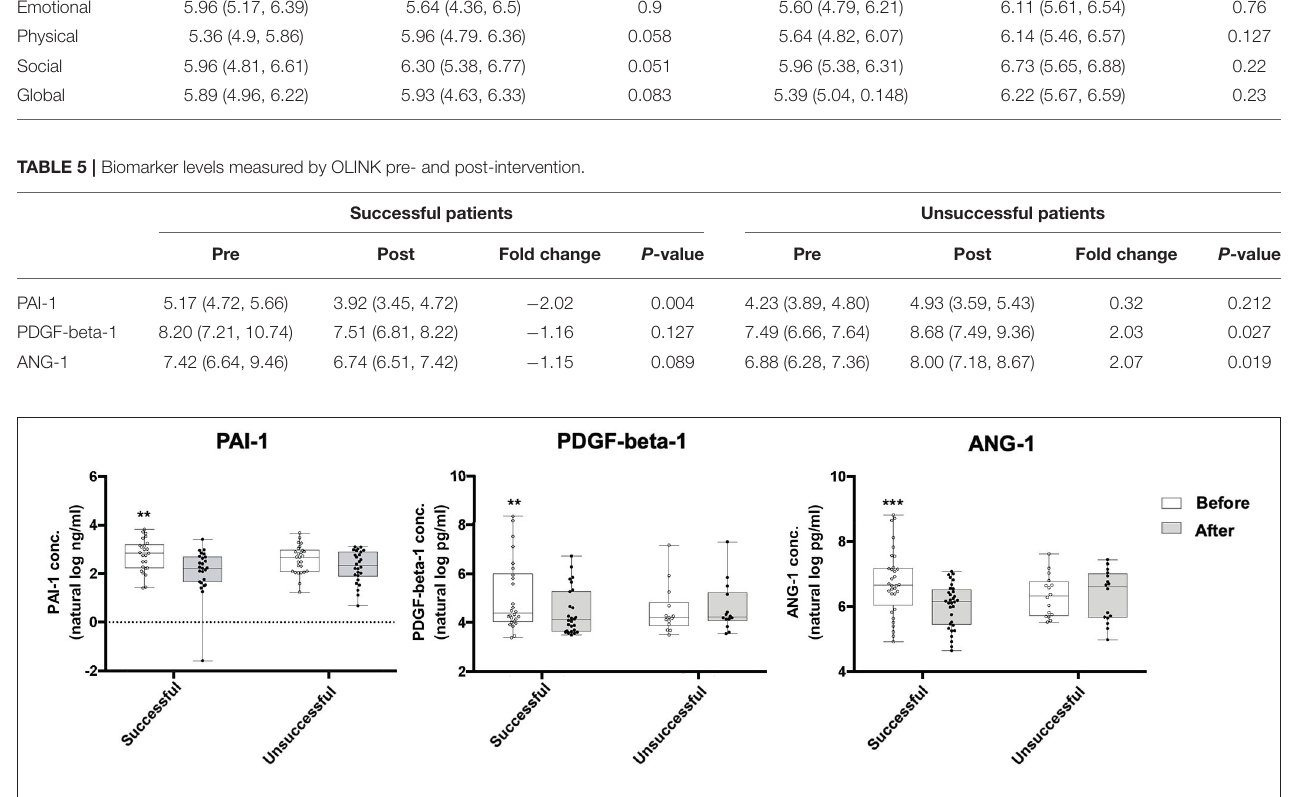
FIGURE 3 | Box and whisker plots comparing ELISA results for the levels of PAI-1, PDGF-beta-1, and ANG-1 in successful and unsuccessful patients before and after engaging in an 8-week exercise program. Successful patients ( n = 35) had a significant decrease in PAI-1 (16.64 vs. 9.38ng/mL, p = 0.0002), PDGF-beta-1 (76.71 vs. 60.32 pg/mL, p = 0.0043), and ANG-1 (788.89 vs. 475.28 pg/mL, p = 0.0001), whereas unsuccessful patients ( n = 17) either showed a non-significant decrease (PAI-1, 14.47 vs. 10.33ng/mL, p = 0.098) or had an increase (PDGF-beta-1, 67.77 vs. 70.82 pg/mL, p = 0.42; ANG-1, 539.4 vs. 693.55 pg/mL, p